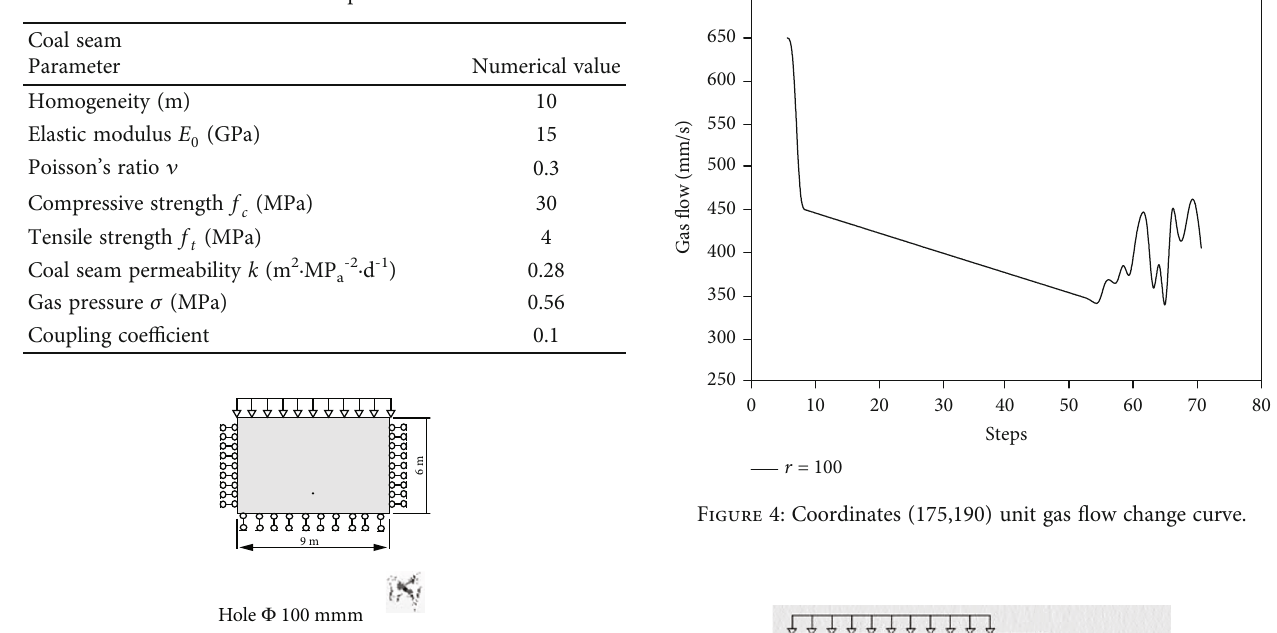
Table 1: Model parameters.